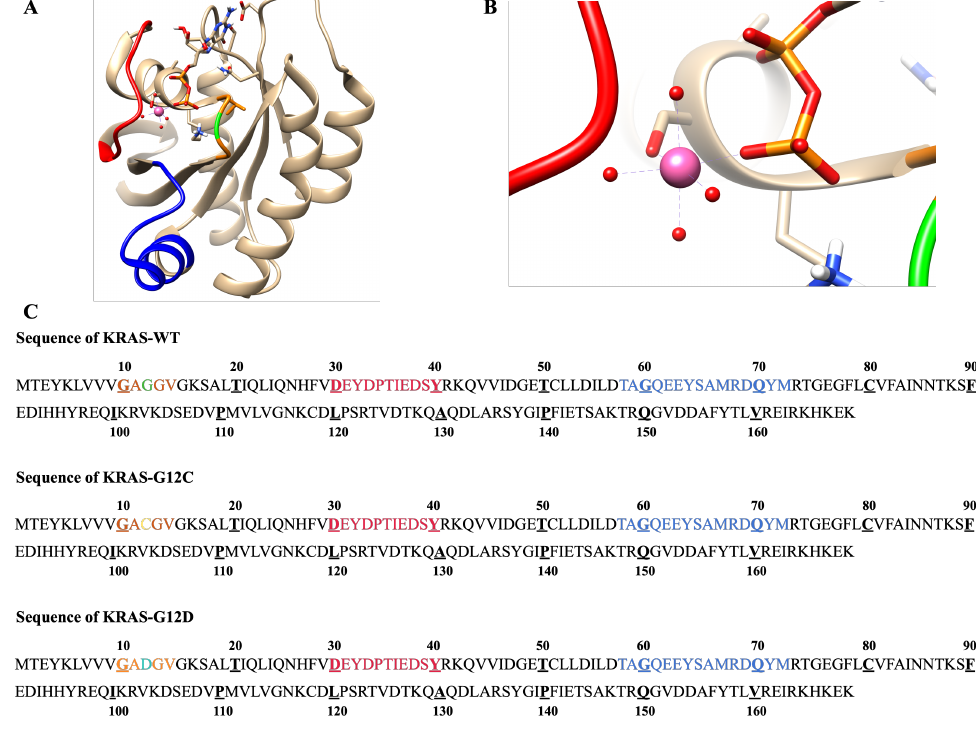
Figure A1. Initial structure and sequence of three KRAS isoforms: ( A ) SW-I (red), SW-II (blue), mutation site GLY12 (green); ( B ) Details of the octahedral structure of Mg 2 + in the crystal structure; ( C ) Sequence of KRAS-WT, KRAS-G12C and KRAS-G12D. G12 (green), C12 (yellow), D12 (cyan).